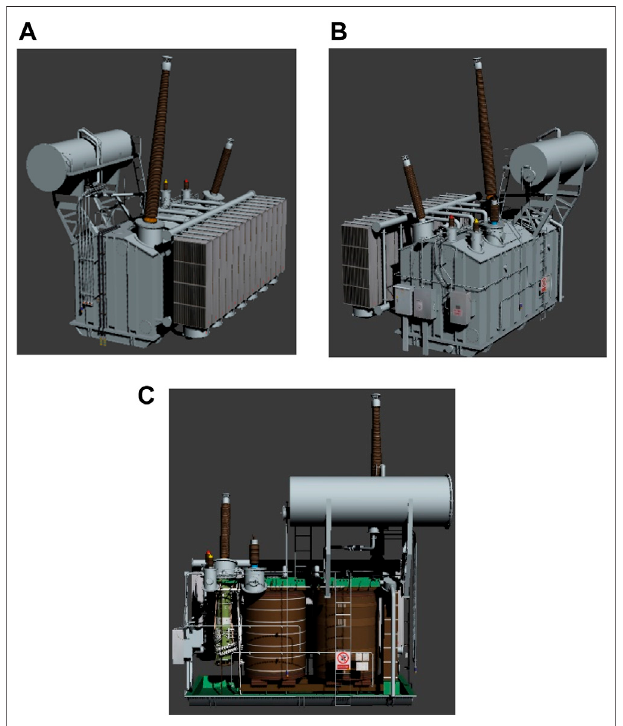
FIGURE 3 | Simulated power transformer.